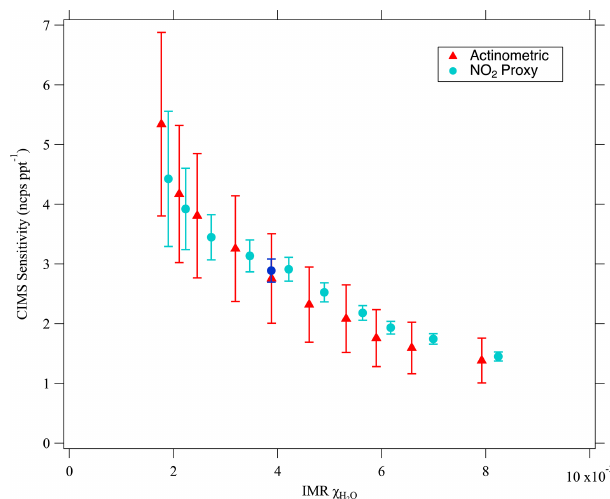
Figure 4. Comparison of the two HONO calibration methods for a range of χ H within the CIMS IMR. The sensitivity determined 2 O by the multipoint calibration (i.e., the Fig. 3 slope) is plotted as the dark blue circle. Error bars represent ± 2 σ uncertainties. [HONO] ranged from 470pptv (at the lowest χ H value) to 7710pptv (at 2 O the greatest χ H value) for the actinometric calibration. [HONO] 2 O similarly ranged from 630 to 7820pptv for the NO 2 proxy calibra-